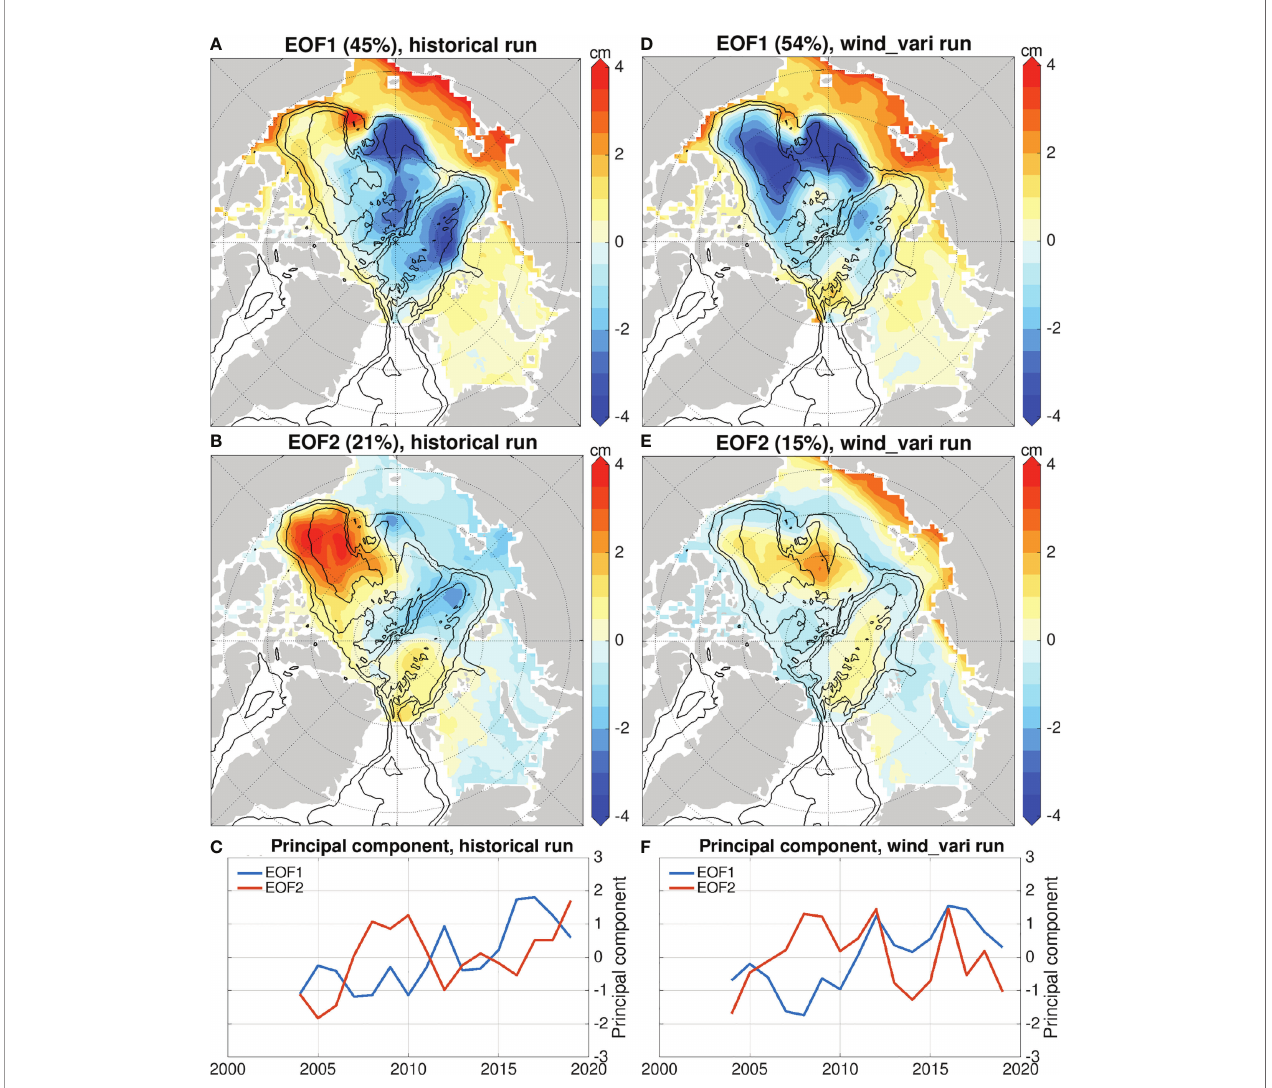
FIGURE 5 | EOFs and principal components of annual sea surface height (SSH). (A, B) The fi rst two SSH EOFs and (C) their corresponding principal components for the 2004 – 2019 period of the historical simulation. (D – F) The same as (A – C) , but for the wind_vari